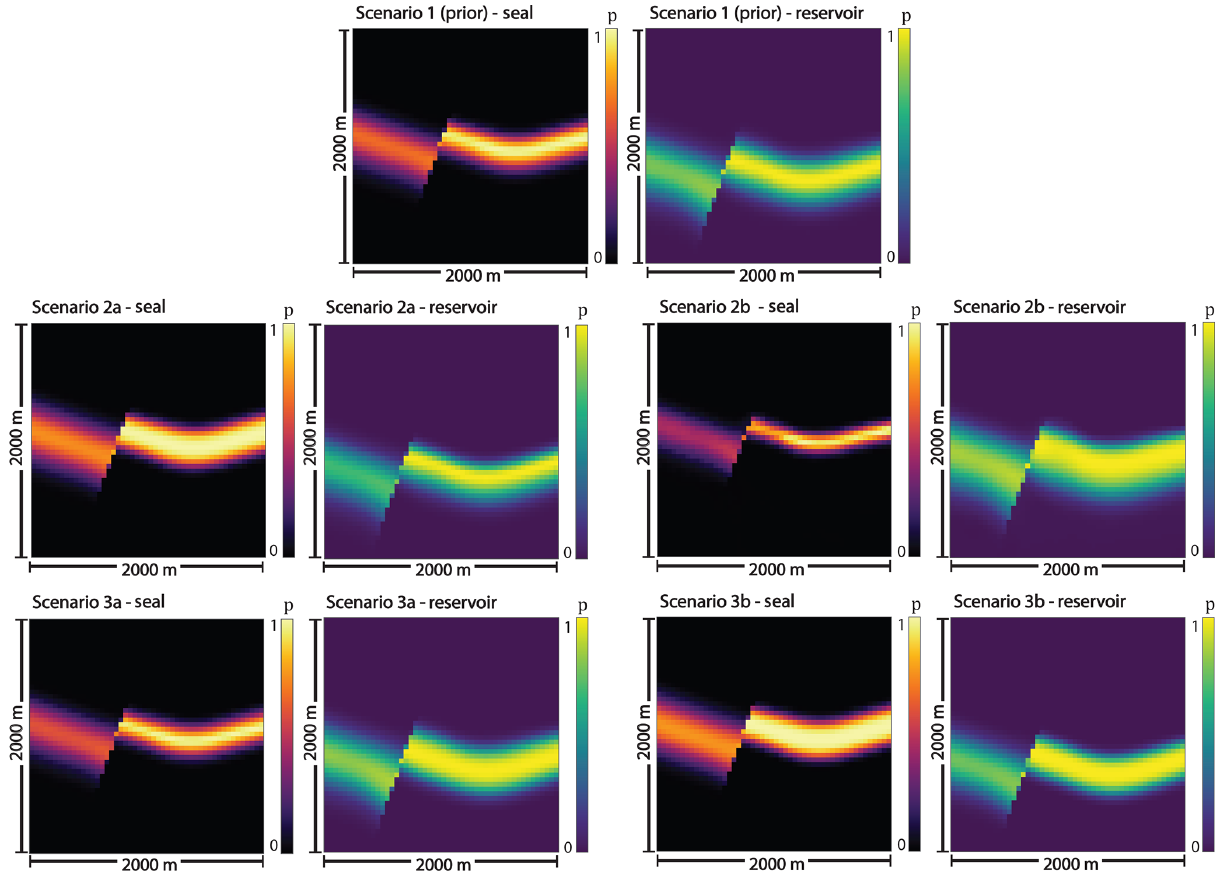
Figure B2. Probability field visualizations for Scenarios 1 to